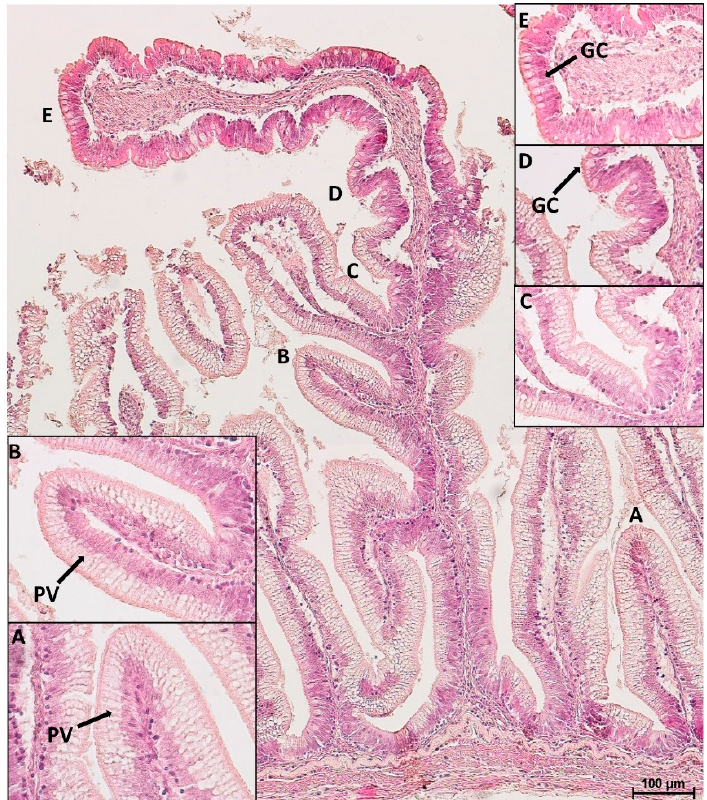
Figure 4. HE stained section of a complex fold in the distal intestine: parietal villi ( A ), as well as villi emerging from the basal part of the fold ( B , C ), were both covered by pinocytotic vacuoles (PV). At one point, the epithelium morphology along the fold, drastically changed: pinocytotic vacuoles tended to disappear ( D ). The apex of the fold presented goblet cells (GC) and non-vacuolated enterocytes ( E ).